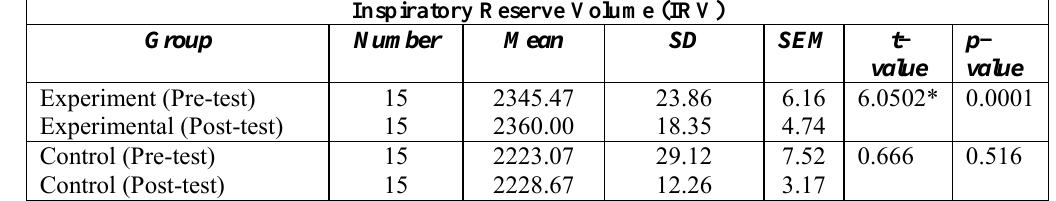
Fig. 9. Descriptive Statistics of Expiratory Reserve Volume (ERV) of (a) Experimental (Pre & Post) and (b) Control (Pre & Post) group of University Level Girls Descriptive Statistics and Paired Sample t-test of Inspiratory Reserve Volume (IRV) of University Level